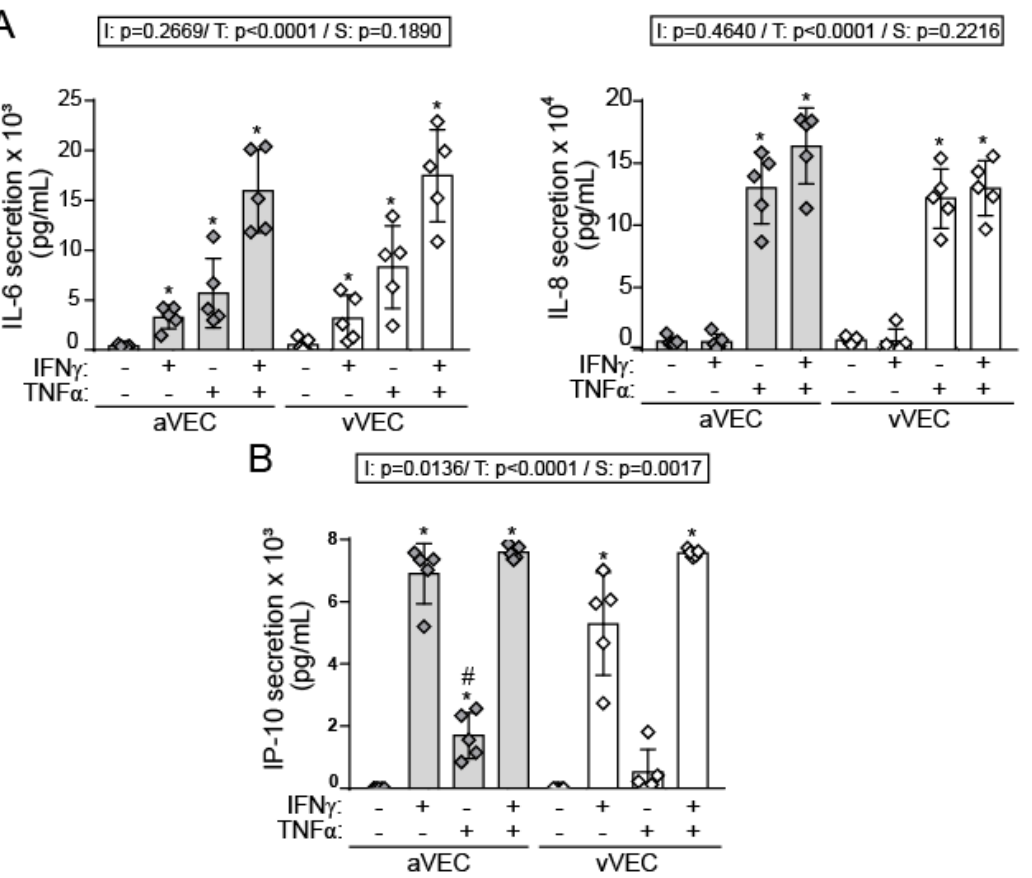
Figure 5. IFN- γ induces IL-6 and IP-10 secretion in side-specific VEC. ( A , B ) aVEC and vVEC were sheared for 48 h and then activated with the indicated ligands for 24. Supernatants were collected to assay cytokine secretion by ELISA. ( A ) IL-6 and IL-8 secretion; n = 5 aVEC and vVEC pairs. ( B ) IP-10/CXCL10 secretion; n = 5. Doses as in Figure 3. Dataset A–B: Mean ± S D. 2-Way ANOVA statistics are shown above the graph; I = interaction between treatment and valve side; T = treatment; S = valve side. * p < 0.05 compared to the control group (Dunnet test). # p < 0.05 compared to the same treatment in the other group (Sidak test).